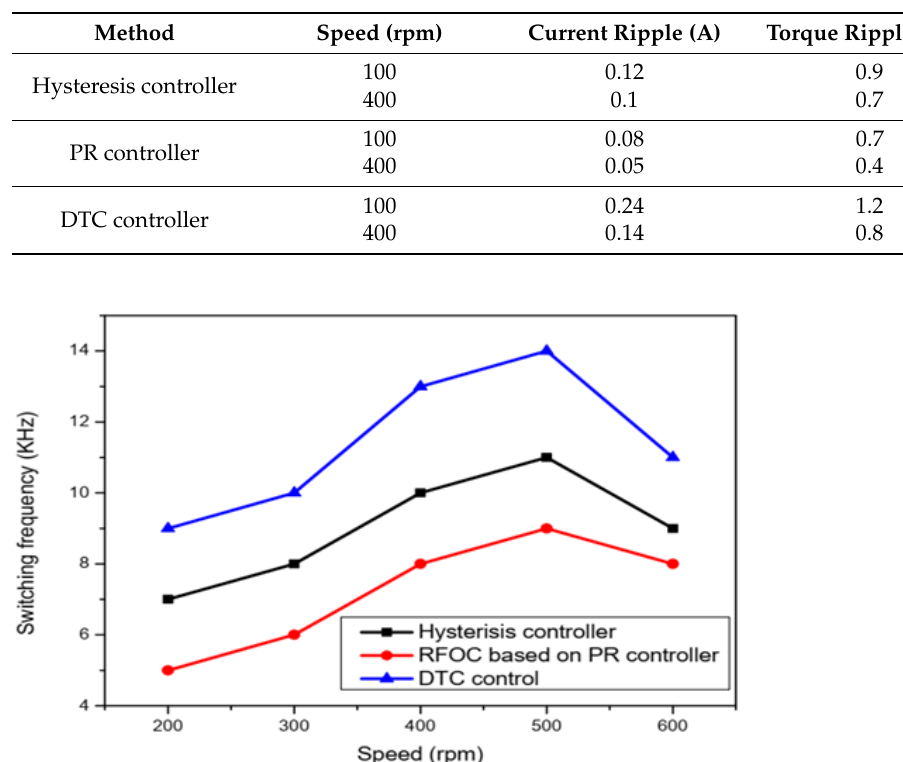
Figure 13. Average switching frequency for the three proposed control techniques.